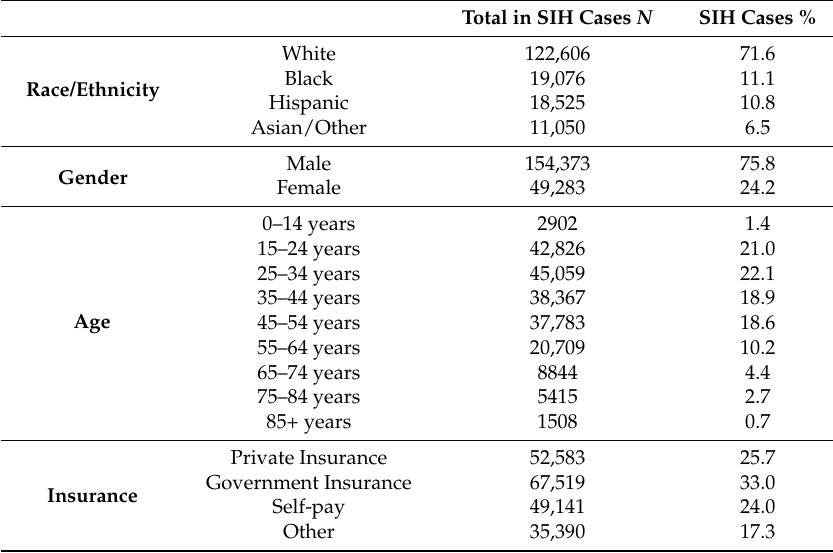
Table 1. Socio demographic characteristics of study participants